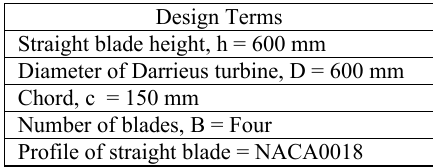
Table 1: Specifications of